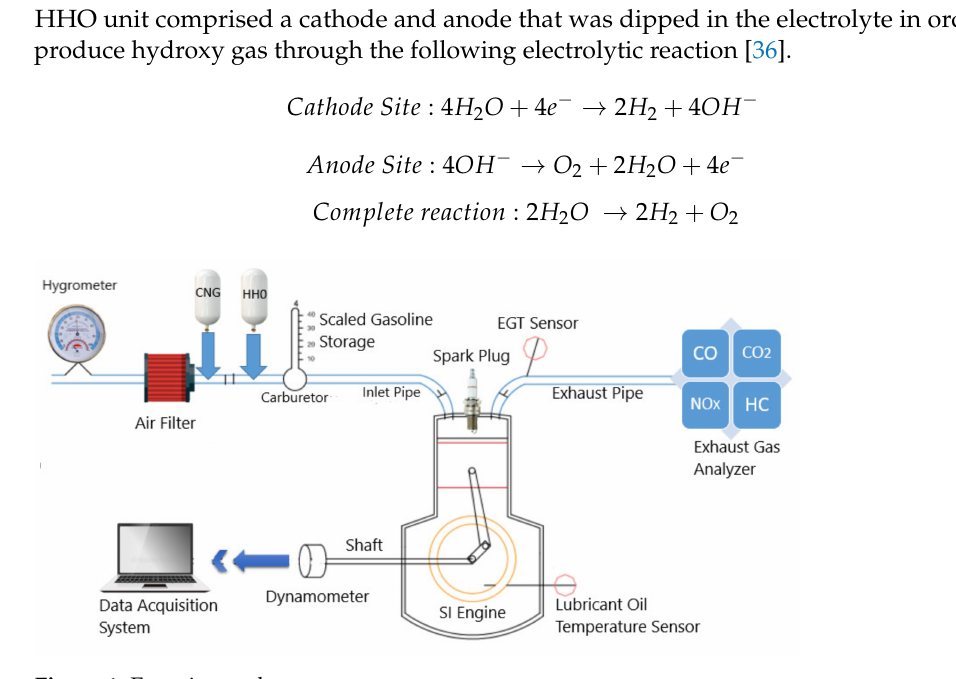
Figure 1. Experimental setup. Table 2. Physiochemical attributes of fuels c